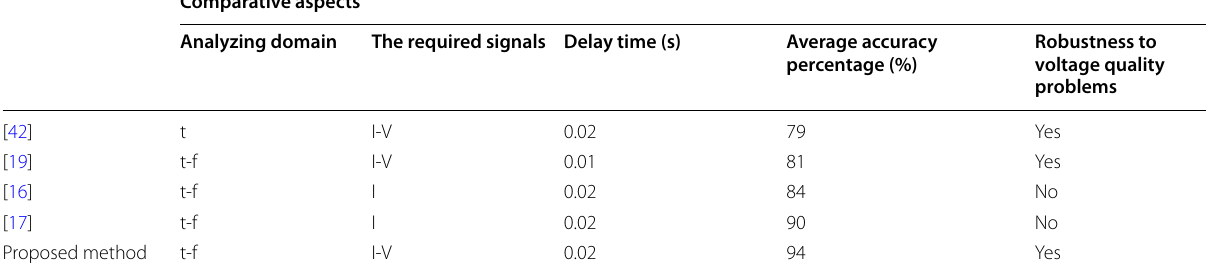
Table 7 Comparison of the proposed method with similar methods based on MCS and MVS Comparative